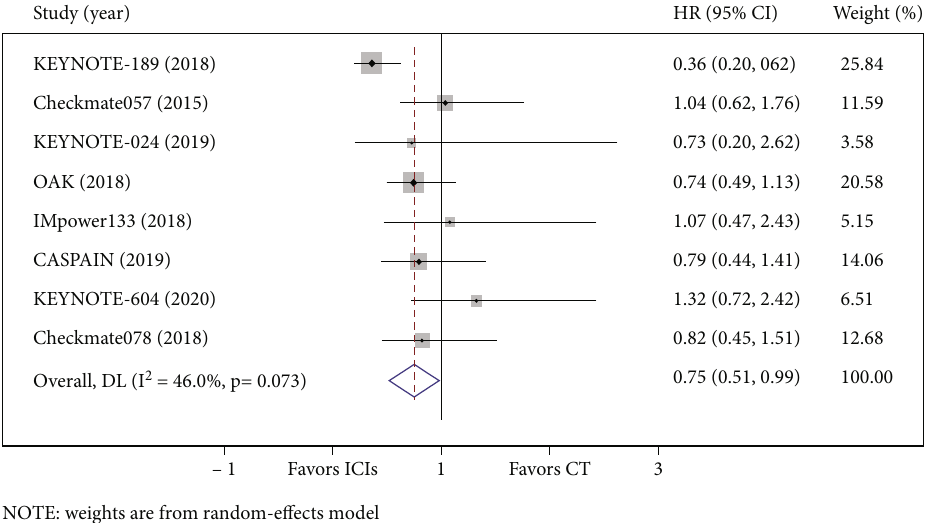
Figure 3: Forest plot of OS between the immune checkpoint inhibitors (ICIs) group and the chemotherapy (CT) group for lung cancer with BM.